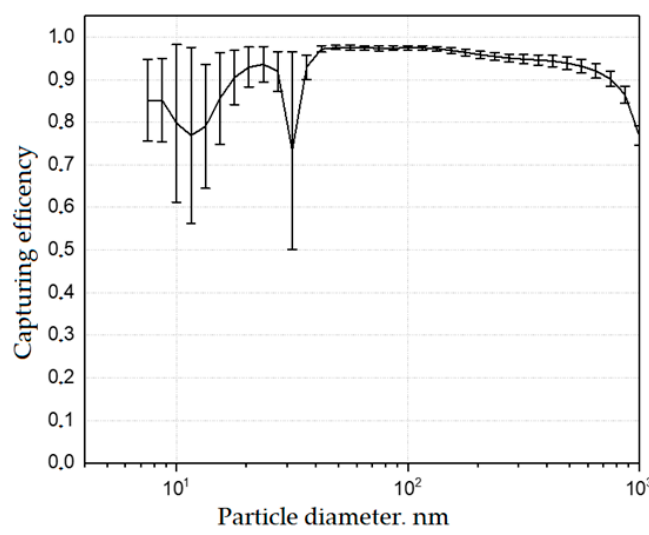
Figure 16. Capturing efficiency for case 1, loading #4.